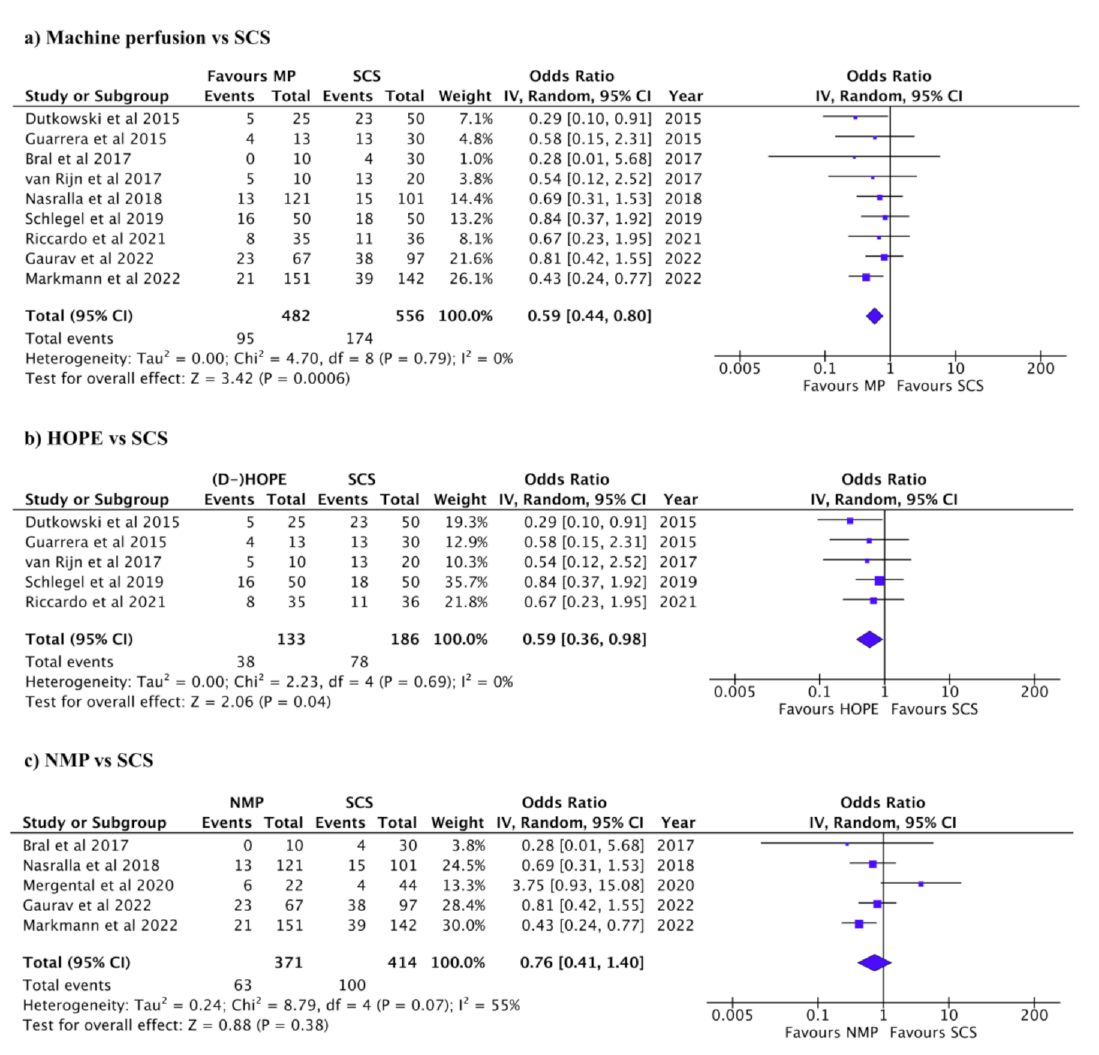
Figure 2. Forest plots for biliary complications. ( a ) Machine perfusion (hypothermic or normothermic) vs. SCS ( P < 0.001). ( b ) HOPE vs. SCS ( P = 0.04). ( c ) NMP vs. SCS ( P =